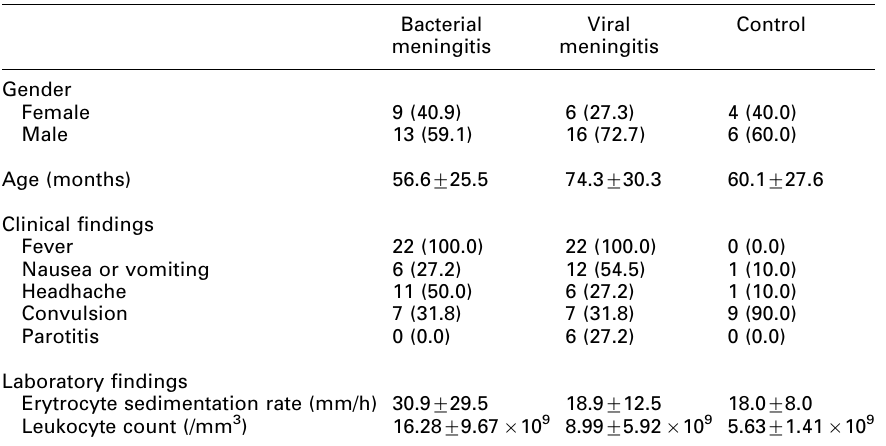
Table 1. Clinical and demographic features of all groups